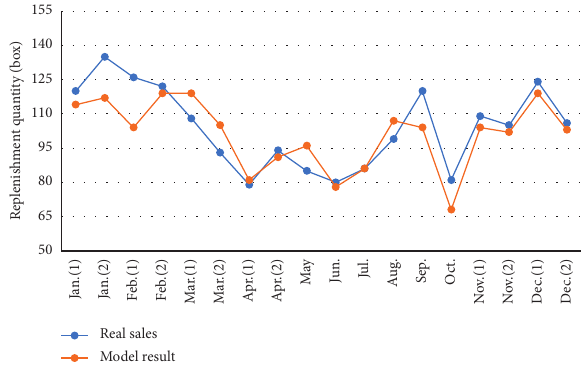
Figure 4: Model simulation